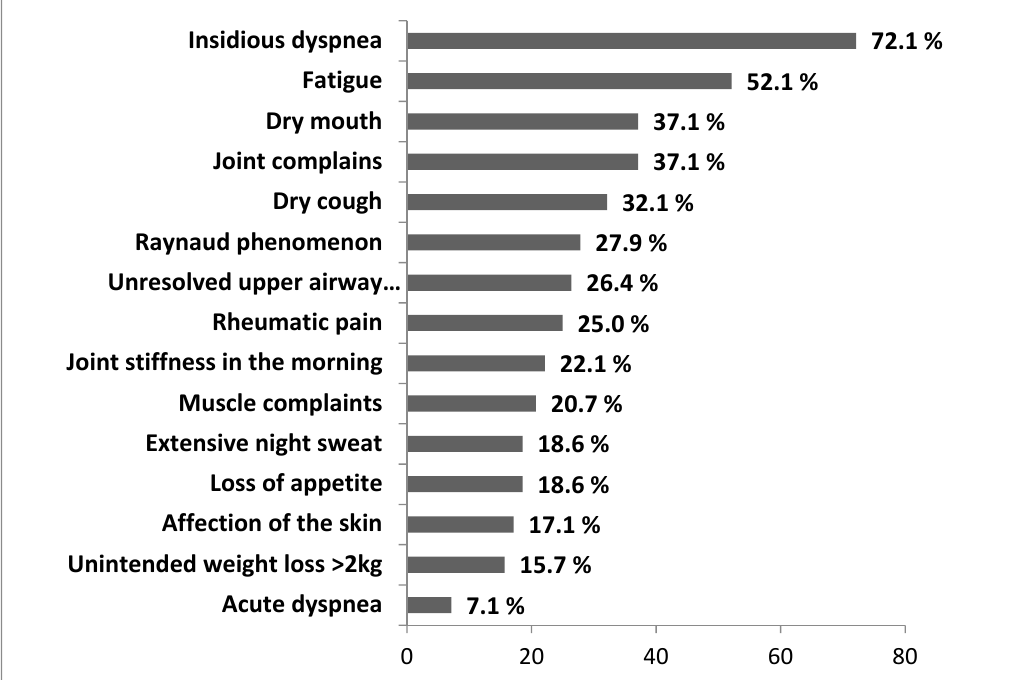
Figure 2. Distribution of self-reported symptoms of uILD patients. Data are presented as percentage of all uILD patients with reported symptoms. Multiple symptoms could be reported.